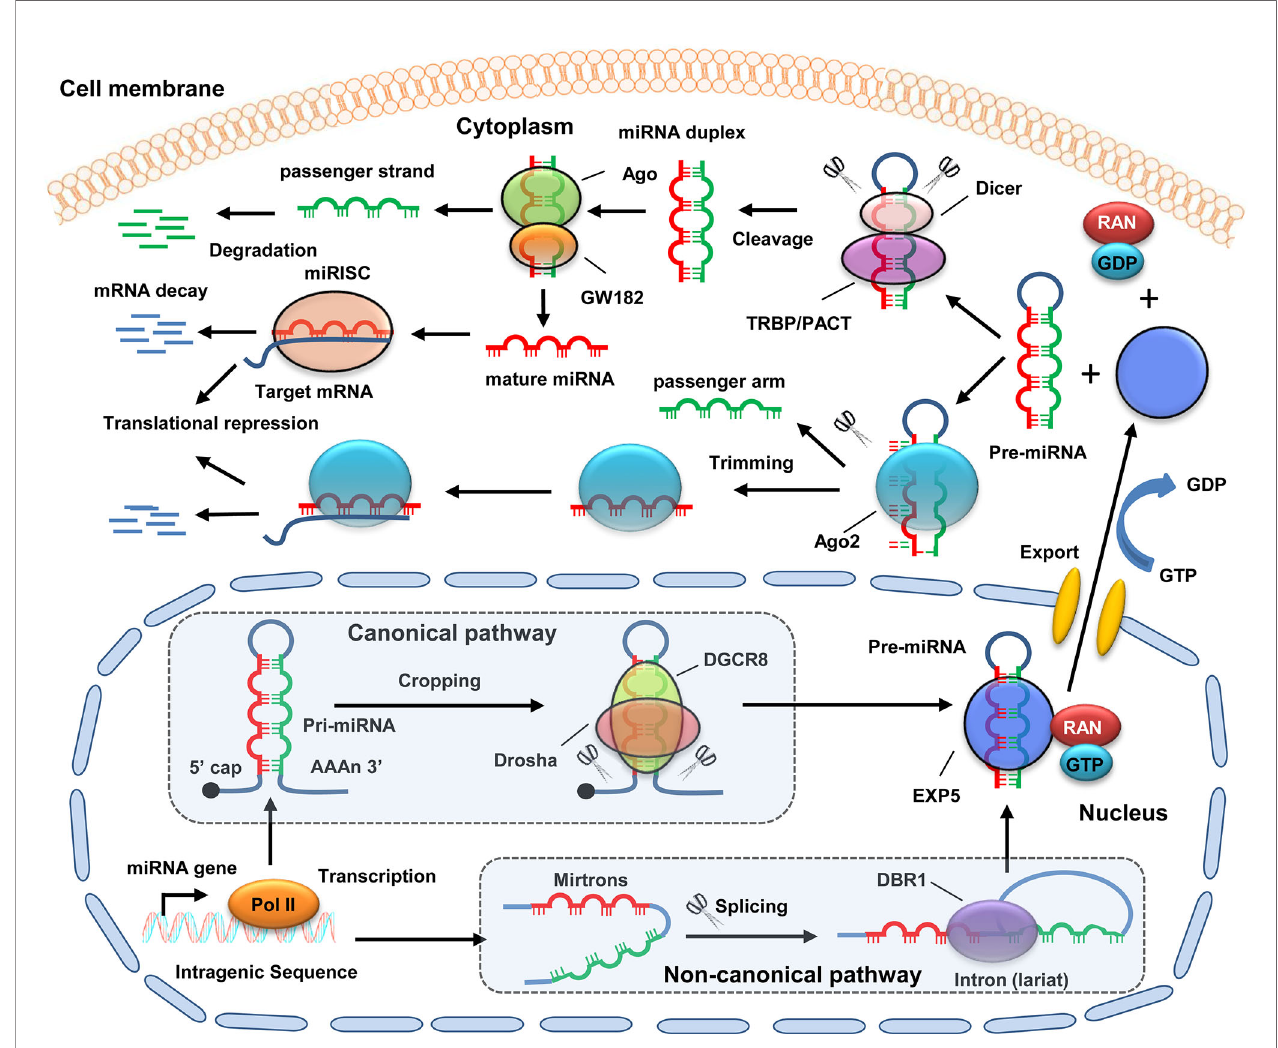
FIGURE 1 | Schematic diagram of miRNA biogenesis. For canonical pathway, pri-miRNA is transcribed by Poll II from original miRNA genes in the nucleus. Then, pri-miRNA is processed into pre-miRNAs by a microprocessor complex consisting of Drosha and DGCR8. For non-canonical pathway, mirtron is transcribed from original miRNA genes. Then, mirtrons undergo splicing to form a lariat structure, which is further processed into pre-miRNAs by DBR1. Next, the pre-miRNAs are exported to the cytoplasm with the help of EXP5, GTP, and RAN. In the cytoplasm, the pre-miRNA is further recognized and processed into double-stranded miRNAs by the Dicer/TRBP/PACT complex. Subsequently, the double-stranded miRNAs are unwound into a guide strand and a passenger strand via Ago protein. The passenger strand is then degraded, whereas the guide strand is incorporated into RISC to form a mature miRNA. MiRNA binds to the 3 ’ -UTR of mRNAs, and ten promotes its degradation. In addition, some pre-miRNAs (e.g., miR-451) can be cleaved by Ago2 to generate an intermediate 3 ’ end, which is then further